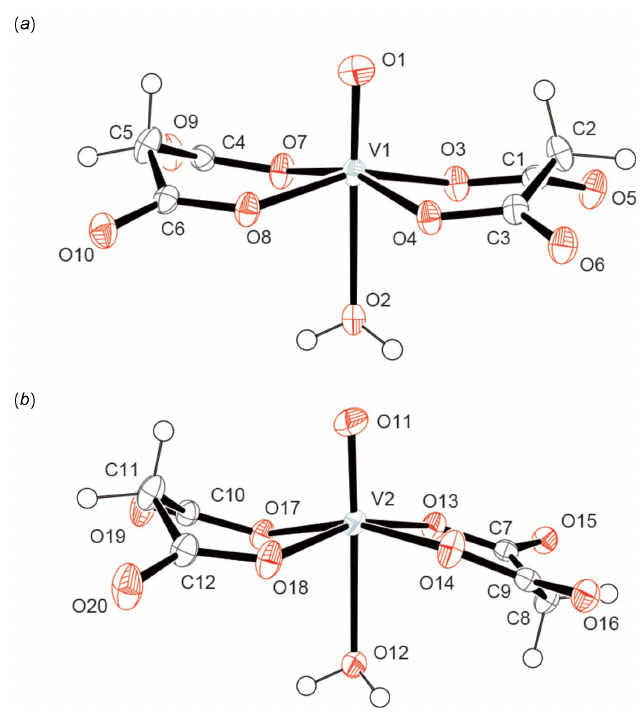
Figure 1 Molecular structures of ( a ) syn isomer and ( b ) anti isomer. Displacement ellipsoids are drawn at the 50% probability level. The NH 4+ counter- cations have been omitted for clarity.